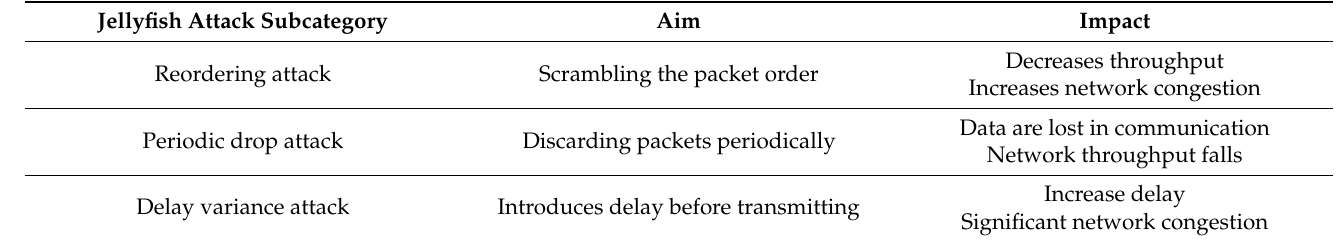
Table 1. Comparison of jellyfish attack categories.